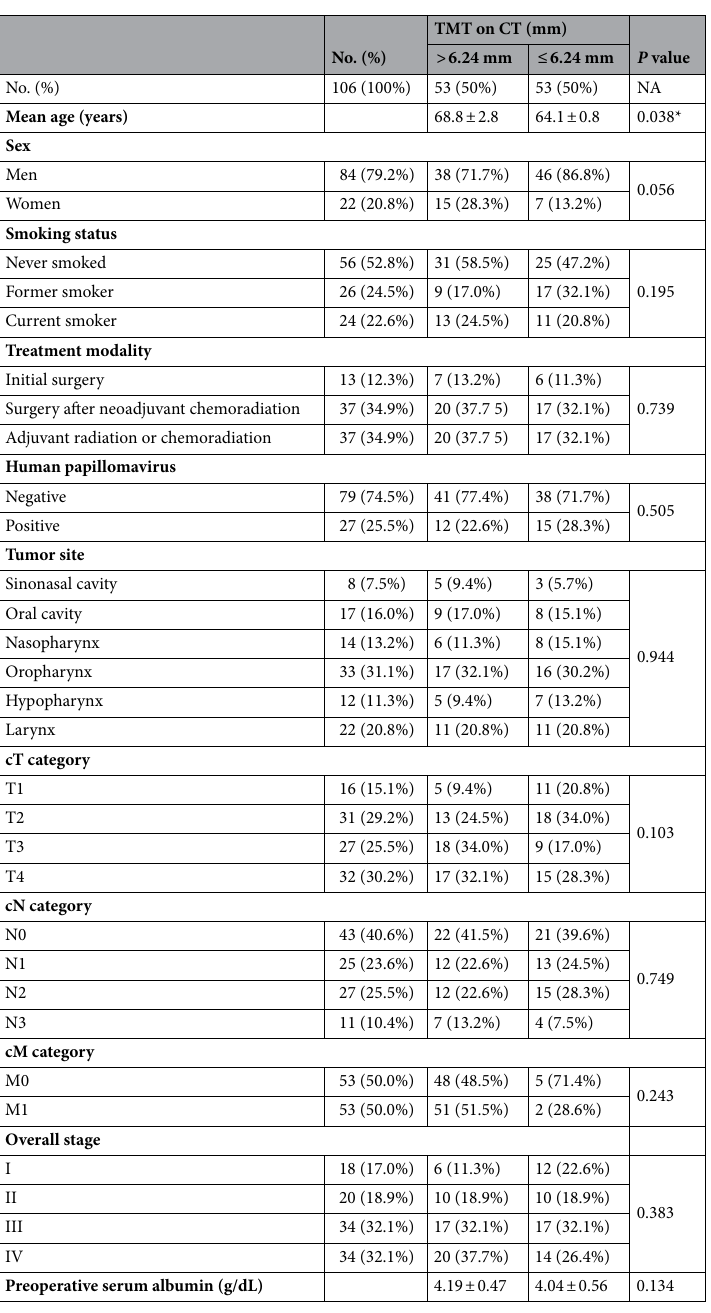
Table 1. Clinical characteristics according to the TMT measurement. The patients were dichotomized according to the median TMT value. TMT temporalis muscle thickness, cT clinical tumor, cN clinical node, cM clinical metastasis, NA not applicable. * P value less than 0.05 indicates statistical